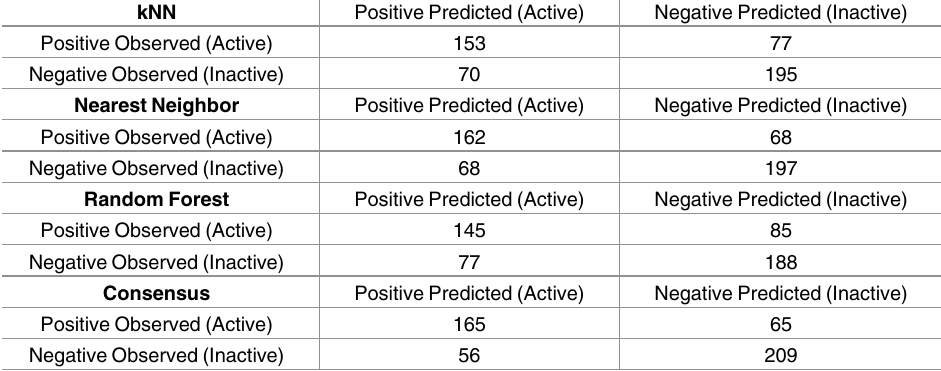
Table 3. Confusion matrix.